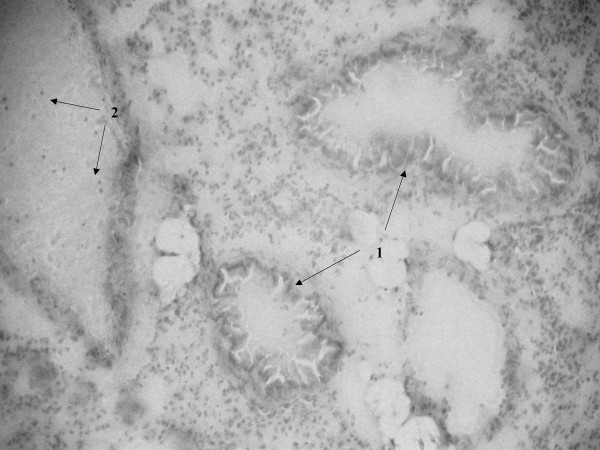
Light microscopy of lung tissue from mice infected with 106CFU of S. pneumoniae. SP-D-/- 24 h post-infection (figure 5), SP-D+/+ 24 h post-infection (figure 6), SP-D-/- 48 h post-infection (figure 7) and SP-D+/+ 48 h post-infection (figure 8). Magnification ×250 for figures 5 and 8, ×400 for figures 6 and 7. See results for description of arrows.